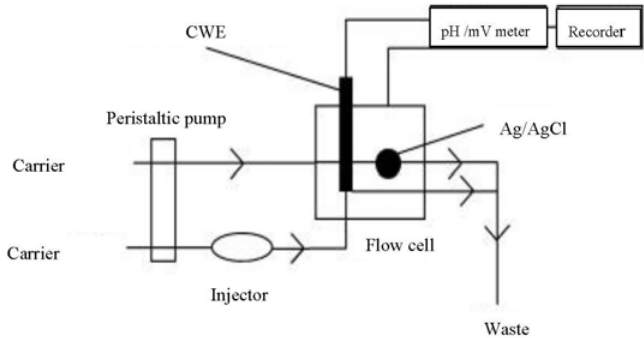
Figure 3. Schematic of the FIA system